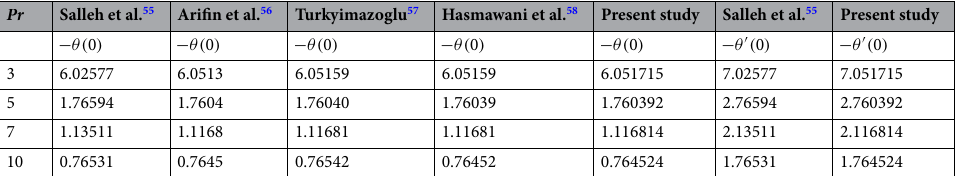
Table 1. The numerical results of θ( 0 ) and θ ′ ( 0 ) for increasing Pr when n = β = M = ξ = Rd = N b = N t =